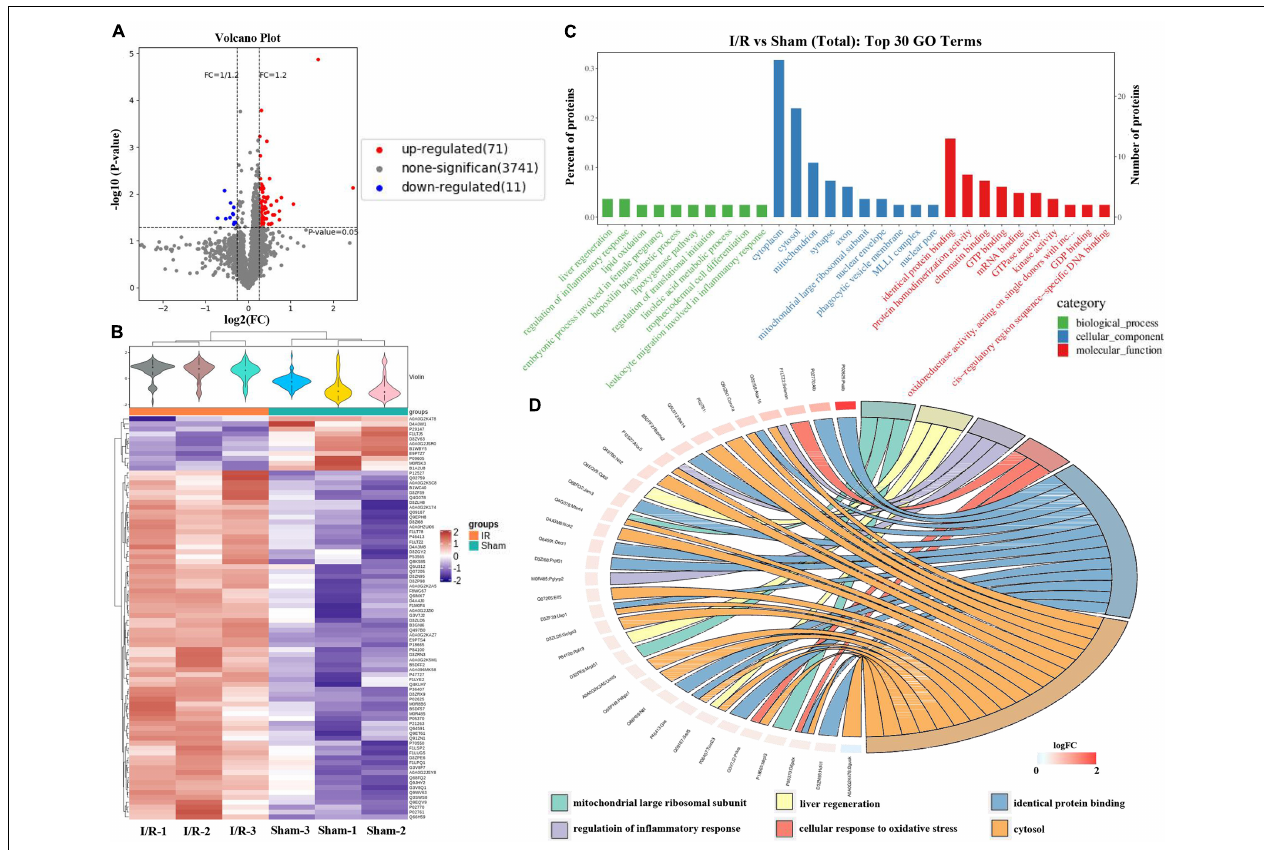
FIGURE 5 | Quantitative proteomics analysis of Ischemia/Reperfusion (I/R) group compared with Sham group. (A) The volcano plot of differentially expressed proteins (DEPs) identified between the I/R group and the Sham group. Red dots represent upregulated DEPs, blue dots represent downregulated DEPs, and gray dots represent no significant proteins. (B) The clustering heat map between I/R and Sham group. (C) The top 30 significantly enriched GO terms for the DEPs identified between the I/R group and Sham group using biological process (BP), cellular component (CC), and molecular function (MF). (D) The chord diagram of GO enrichment analysis, displaying the first 6 GO terms are cytosol, identical protein binding, cellular response to oxidative stress, regulation of inflammatory response, liver regeneration, and mitochondrial large ribosomal